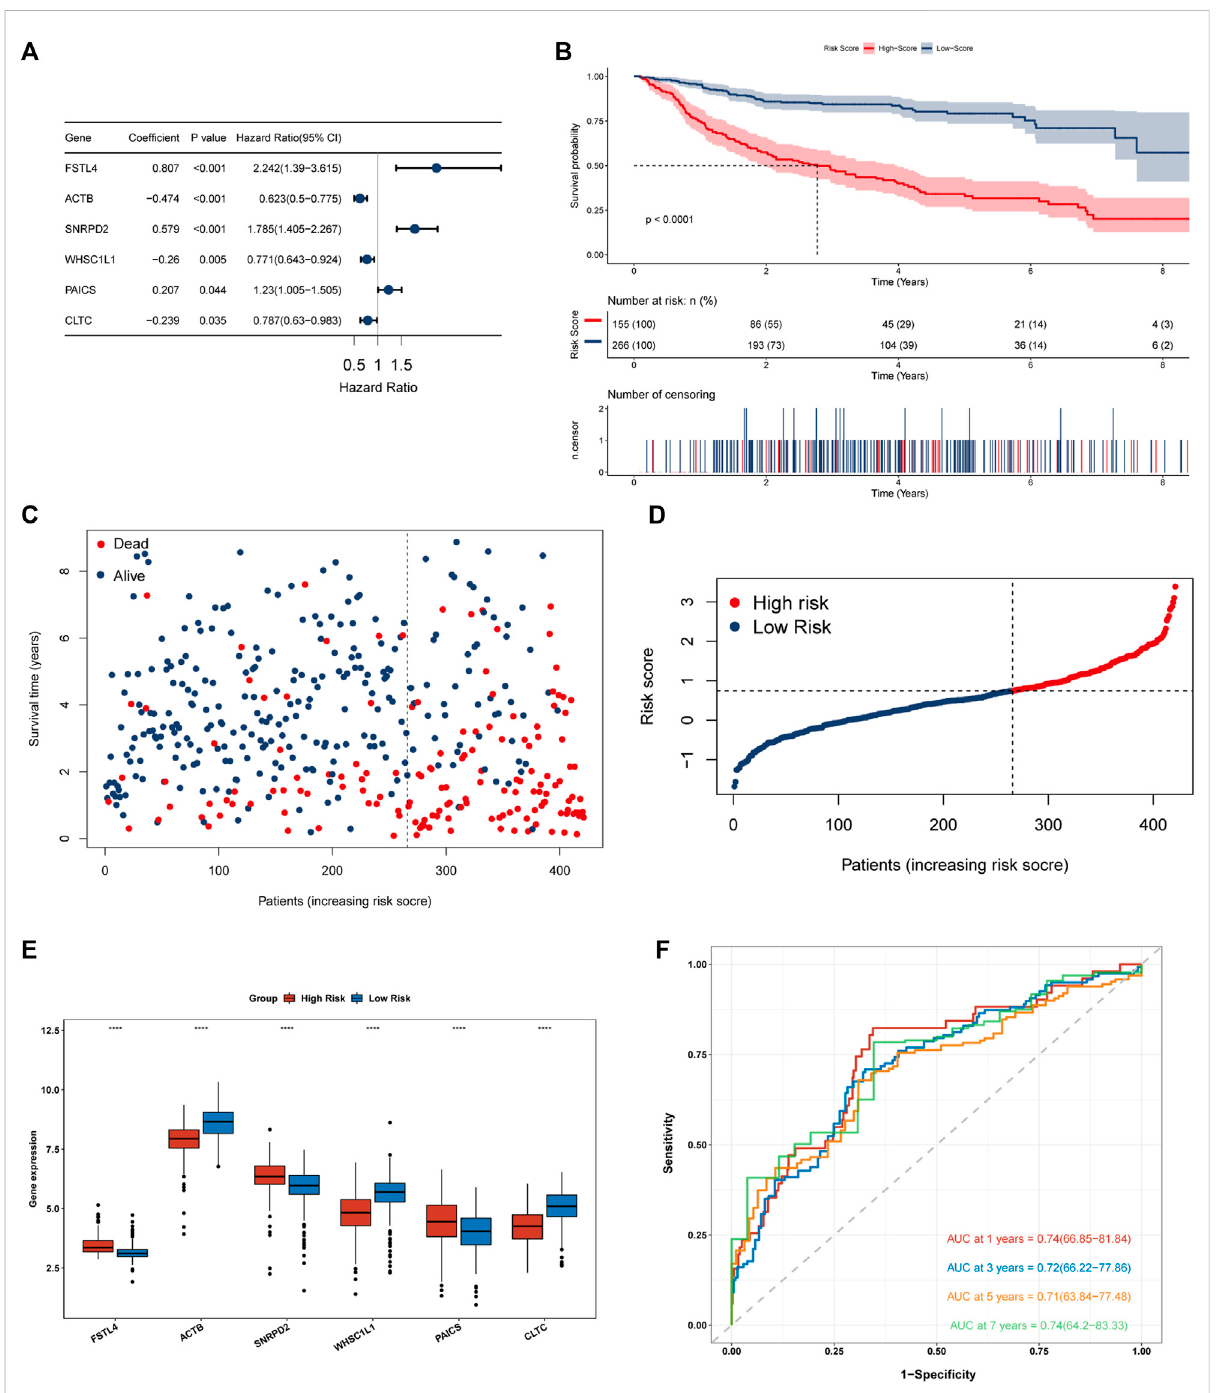
FIGURE 6 Construction and evaluation of a 6 necroptosis-related genes prognostic model. (A) Forest plot of 6 genes multivariate cox regression. (B) Kaplan-Meier survival analysis for the training set (GSE31312). (C,D) Heat map of risk scores and survival status of 421 DLBCL patients in the training dataset. (E) Differential expression of 6 modeled genes in the high and low risk groups in the training dataset, where red box represents high risk and blue represents low risk. (F) A Time-ROC curve analysis of the signature in training